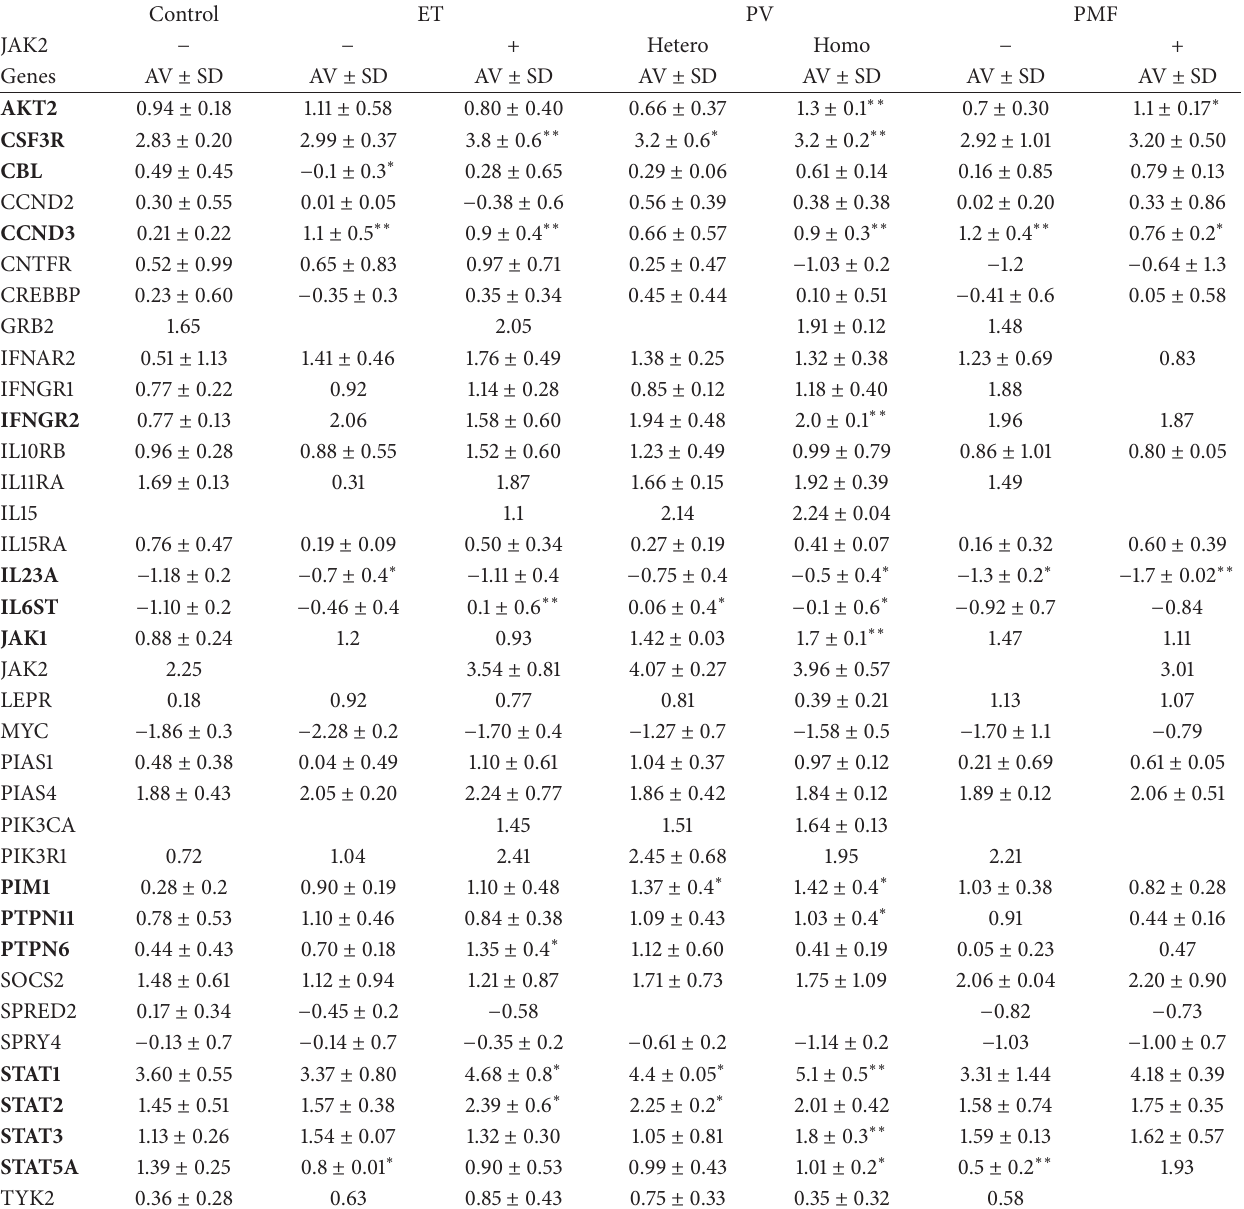
Table 2: Statistically significant genes related to JAK-STAT pathway in CD34 + cells of MPNs according to JAK2 V617F mutant allele